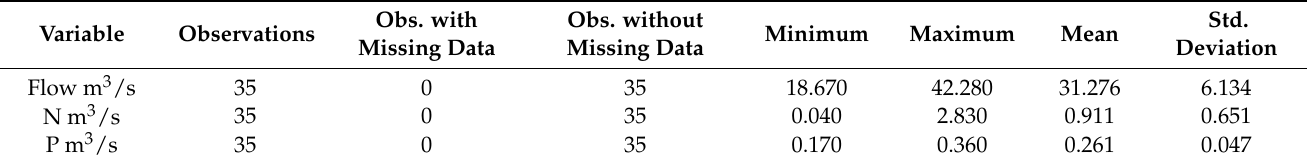
Table 10. Summary statistics for correlation of flow, N and